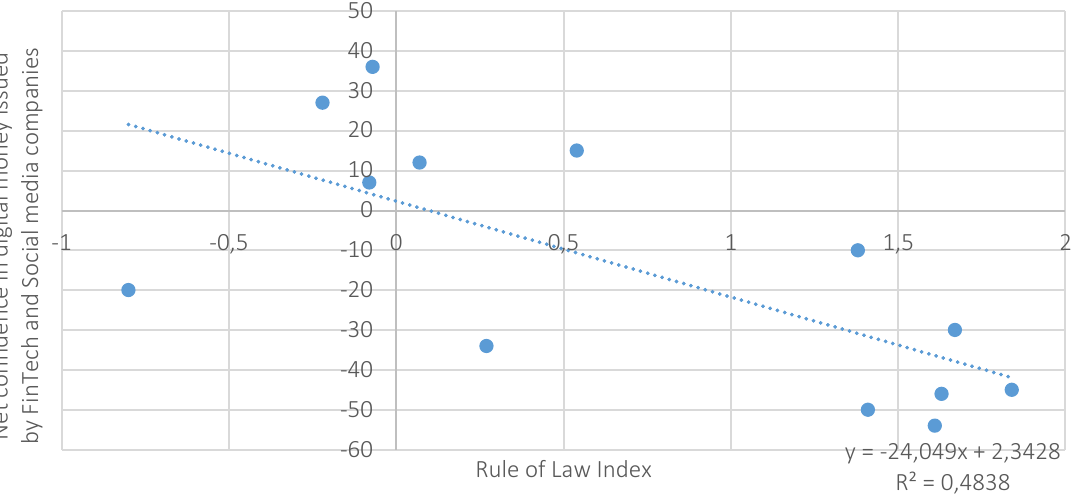
Figure А4. Confidence in privately issued digital money and the rule of law